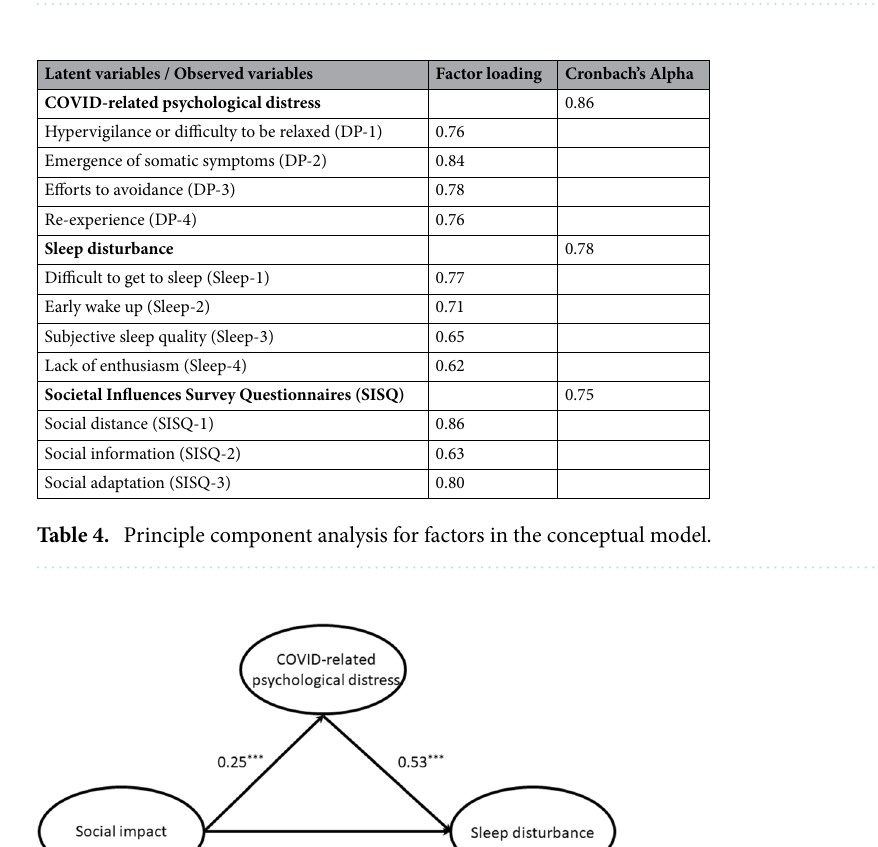
Table 3. The correlation matrix of observed variables. *: P < 0.05; 1 = DP-1; 2 = DP-2; 3 = DP-3; 4 = DP-4; 5 = Sleep -1; 6 = Sleep -2; 7 = Sleep -3; 8 = Sleep -4; 9 = SISQ-1; 10 = SISQ-2; 11 = SISQ-3.